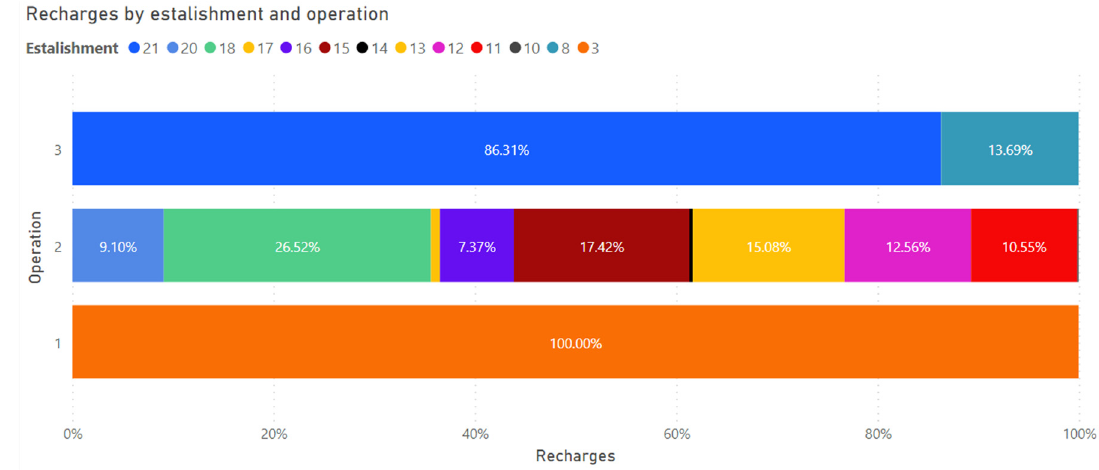
Figure 6. Recharging sessions by establishment and operation.